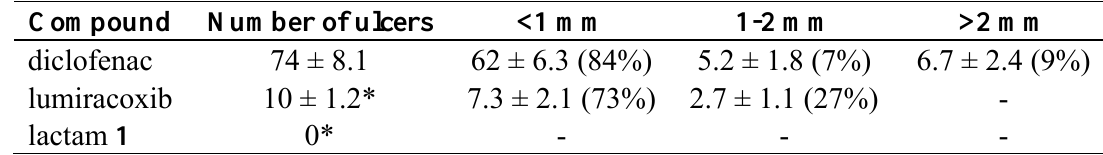
Table 1. Ulcerogenic effect of diclofenac, lumiracoxib and lactam (1) in rats (n = 6, mean ±